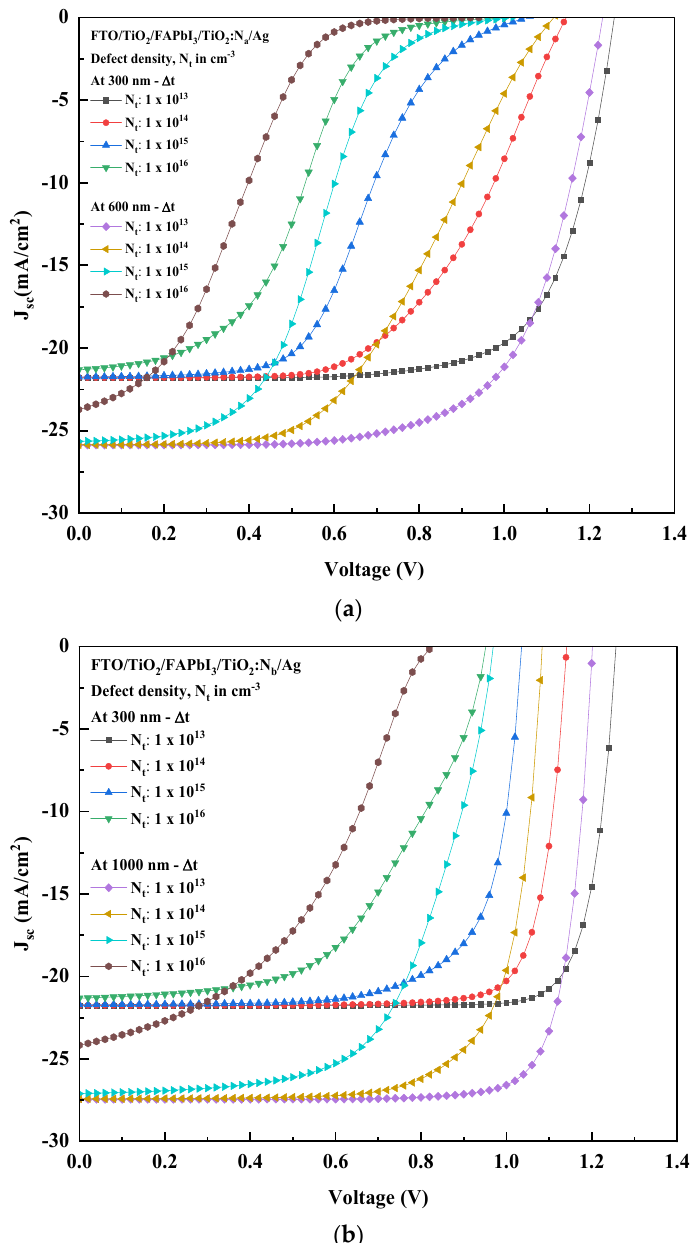
Figure 6. ( a ) J-V curve for the FTO/FAPbI 3 /TiO 2 :N a recipe with ∆ N t . ( b ) J-V curve for the FTO/FAPbI 3 /TiO 2 :N b recipe with ∆ N t